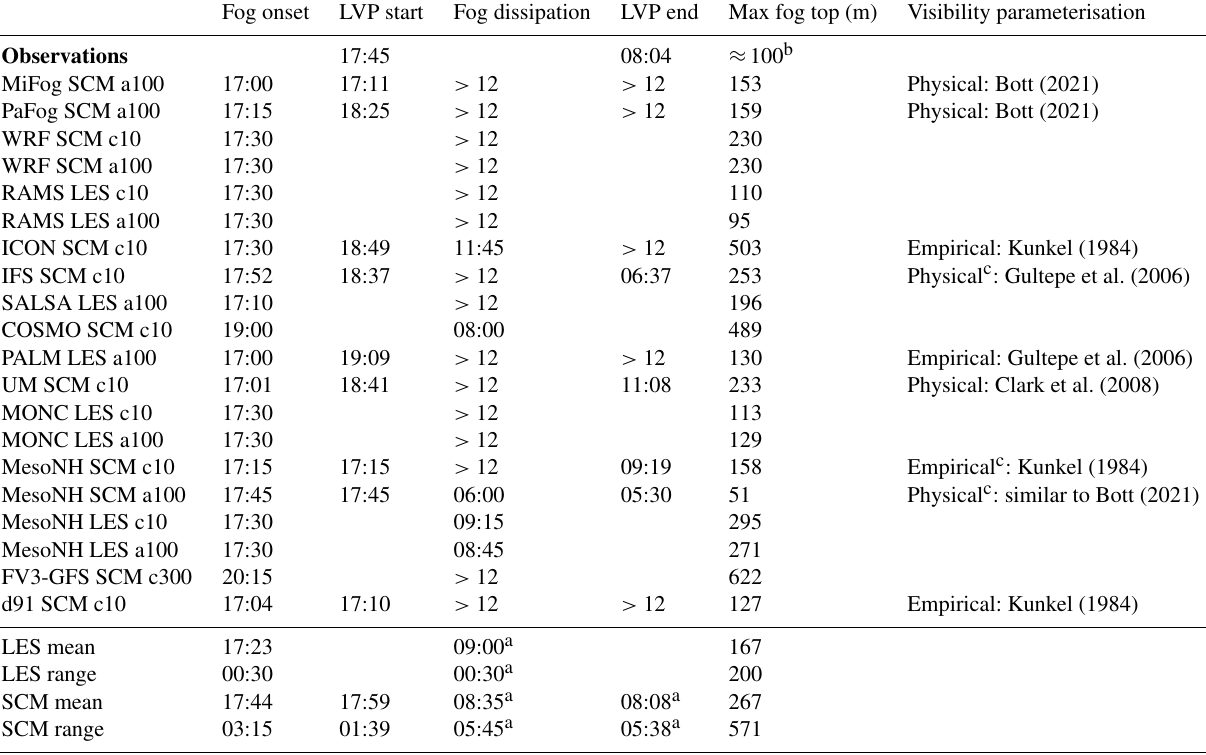
Table 4. Selected forecasting metrics for each model, as observed, and the mean and range of results for the LES and SCM models combined. Fog onset/dissipation is defined by liquid water below 60m, whilst typical airfield low-visibility procedures (LVPs) are defined by visibility < 600m and cloud base < 60m. “ > 12” denotes models which did not dissipate fog by the end of the simulation. Fog